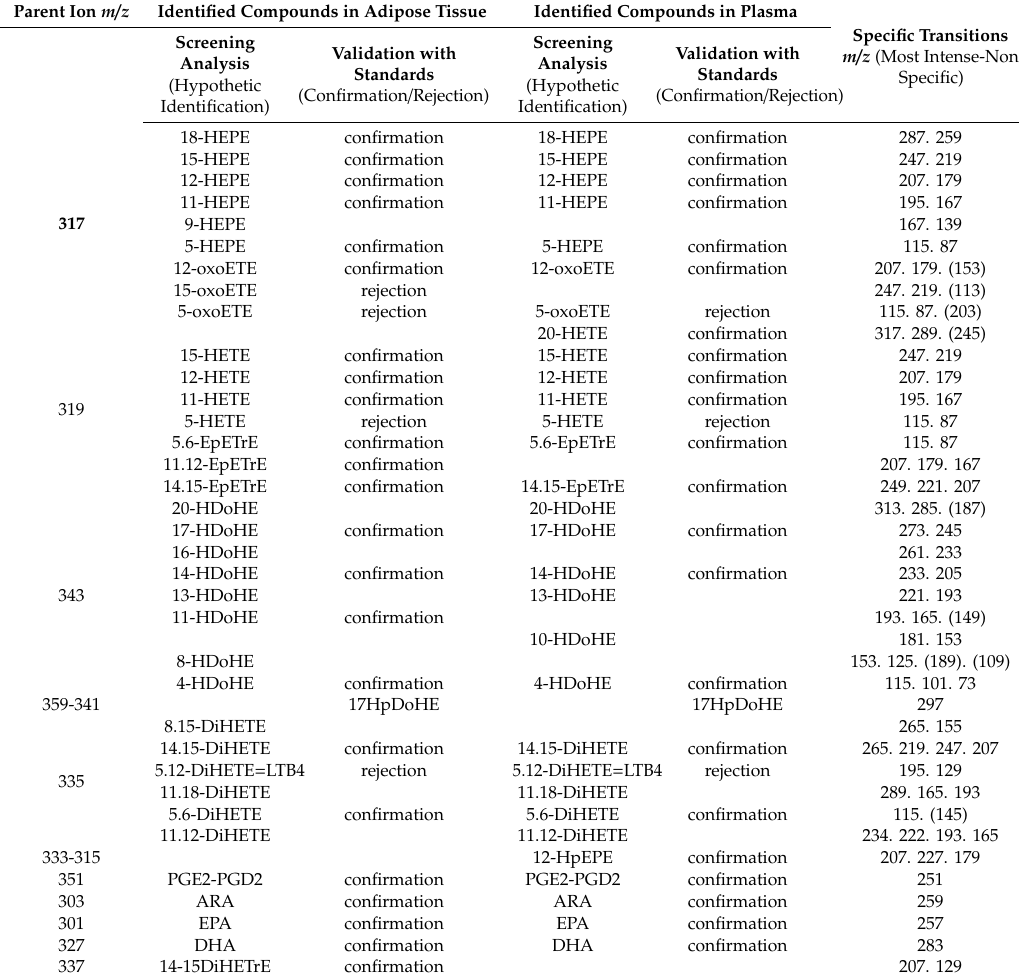
Table 4. Compounds tentatively identified in adipose tissue and plasma, validation with standards and specific transitions used for our hypothetical